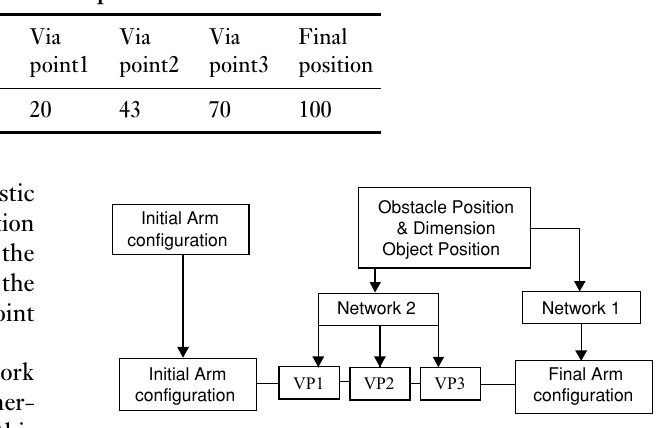
Figure 5 Net of neural